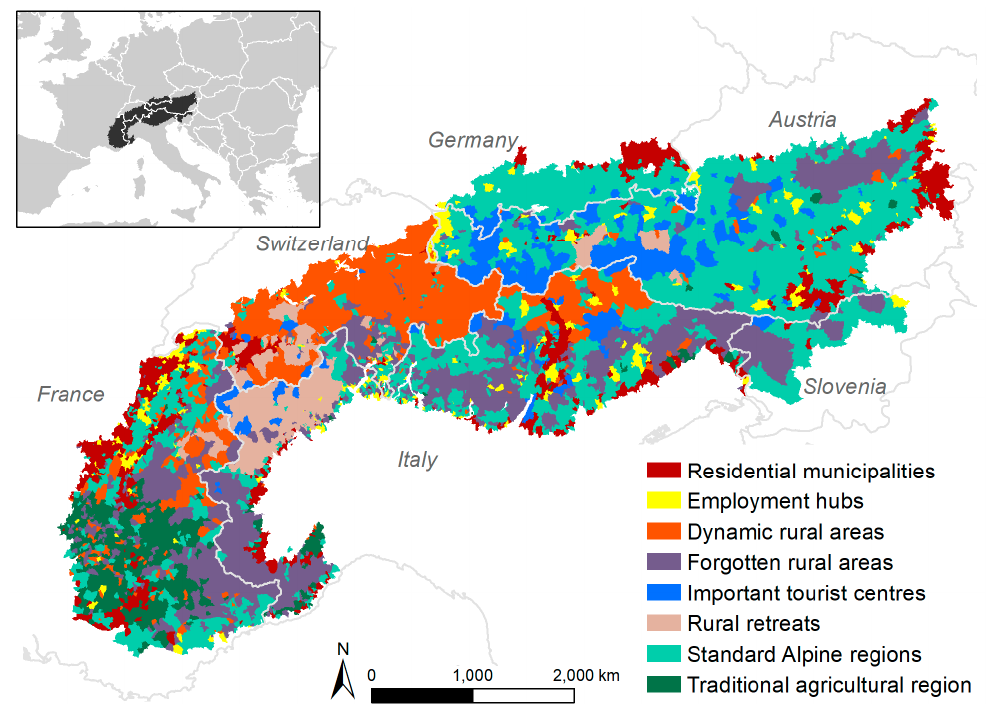
Figure 1. Location of the European Alps in Europe (small map), and the eight social–ecological regions in the study area, as identified by Tappeiner et al. [61] (large map). Authors own elaboration.